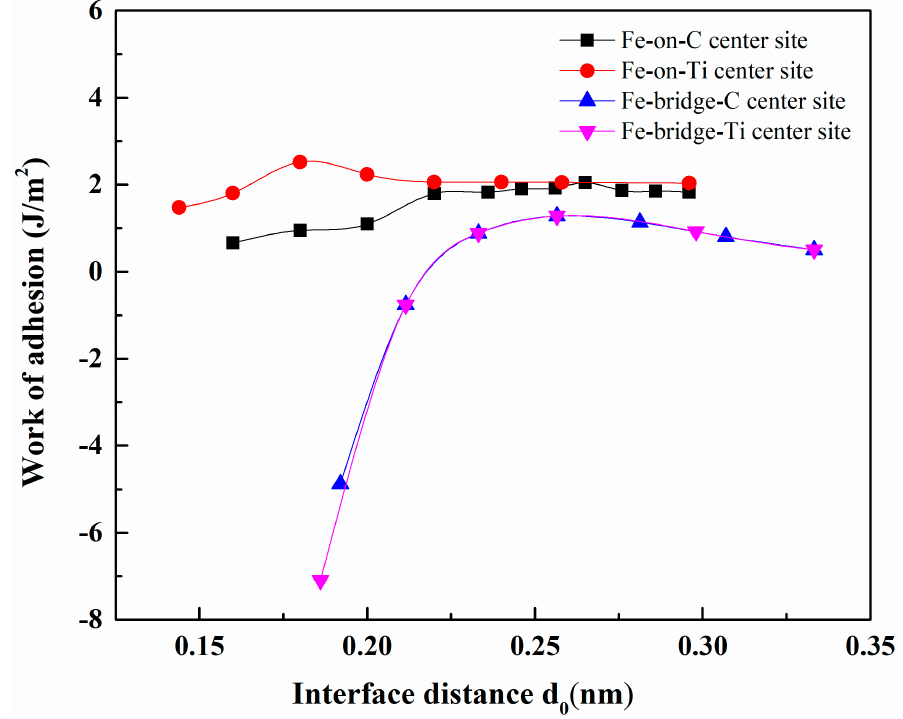
Figure 3. Universal binding energy curves for TiC / γ -Fe interfaces. Table 4. Interfacial distance, adhesion work and interfacial energy of TiC / Fe after full